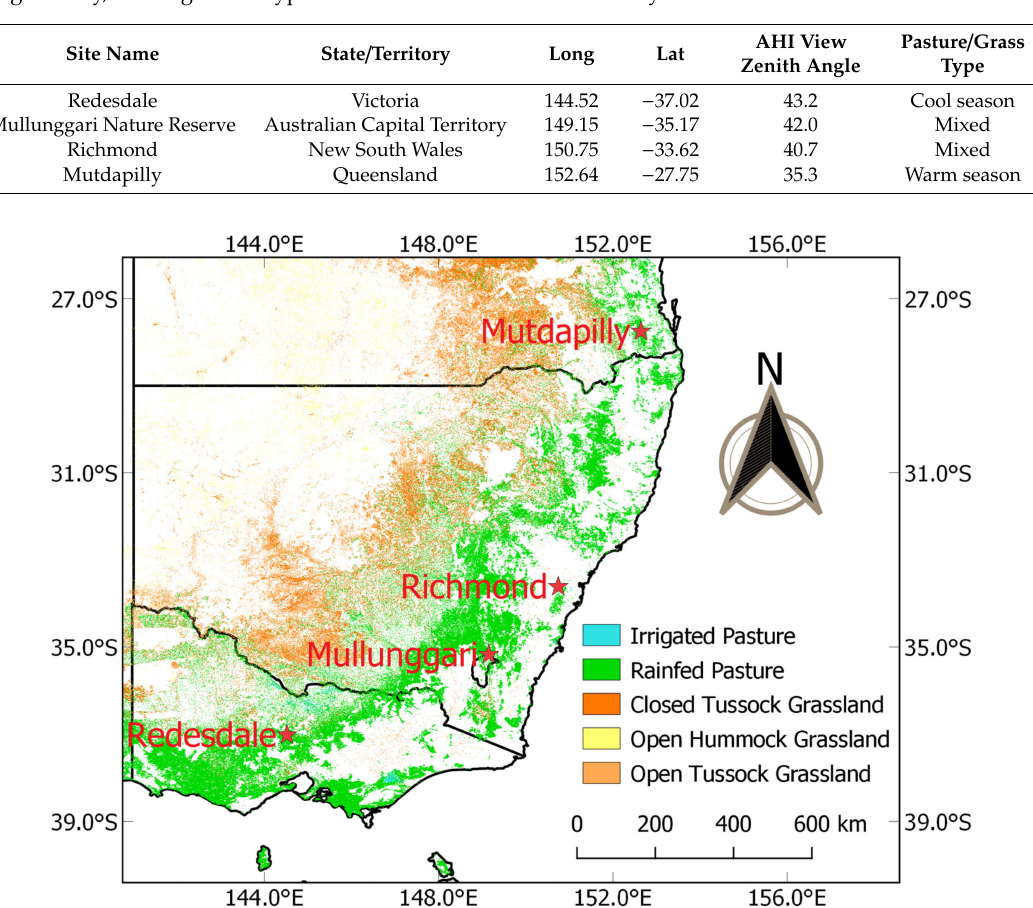
Figure 1. Location of the four Australian grassland / pasture sites on the Dynamic Land Cover Data (DLCD) map across a range of latitudes. The DLCD map (version 2.1) is from Geoscience Australia, http: // www.ga.gov.au / scientific-topics / earth-obs / accessing-satellite-imagery /